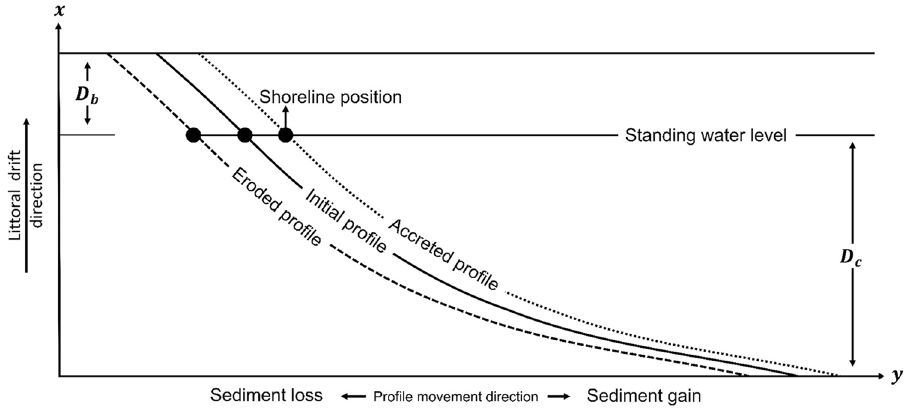
Figure 3. One-line approach used for simulating shoreline change in hybrid 2D/one-line models, such as MIKE21 51 . Shoreline change is a function of the shore-normal movement of the active coastal profile (beach berm— D b —to closure depth— D c ). A gain (loss) in sediment shifts the active coastal profile seaward